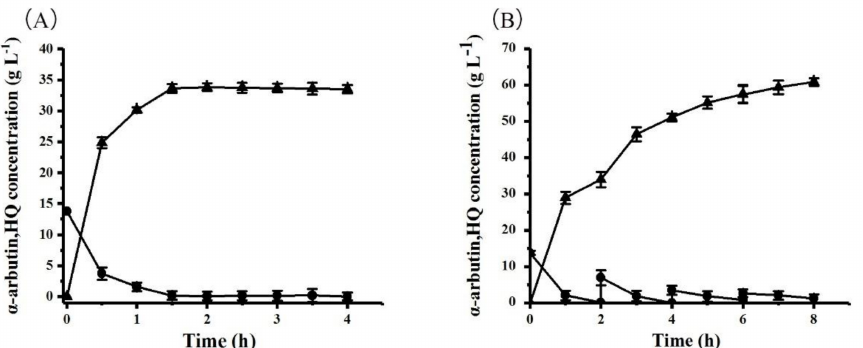
Figure 6. Time course for ( A ) batch and ( B ) fed-batch bioconversion of HQ to α -arbutin. Filled triangles represent concentration of α -arbutin; filled circles represent concentration of HQ.